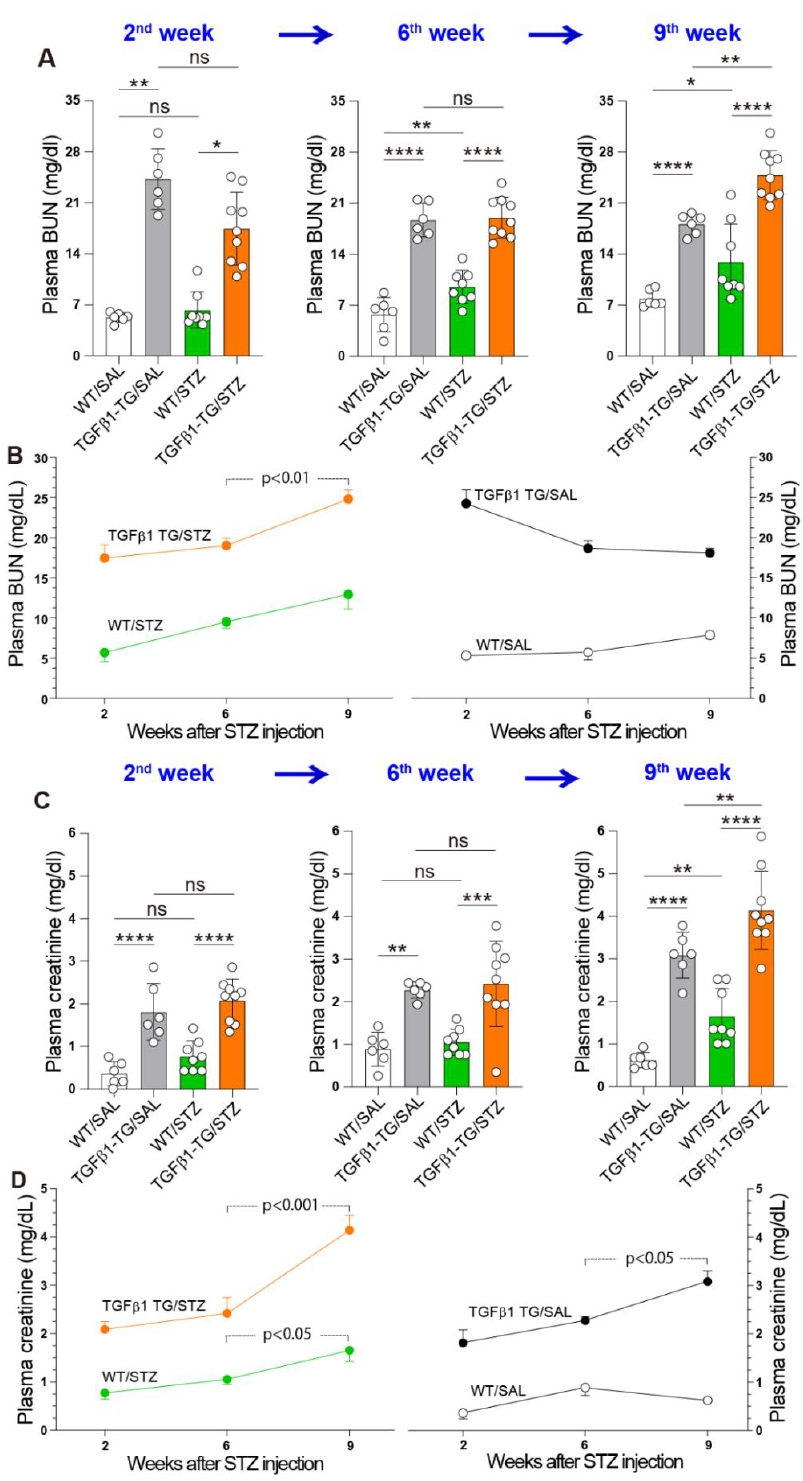
Figure 6. Progressive renal dysfunction in diabetic transforming growth factor β 1 transgenic mice.